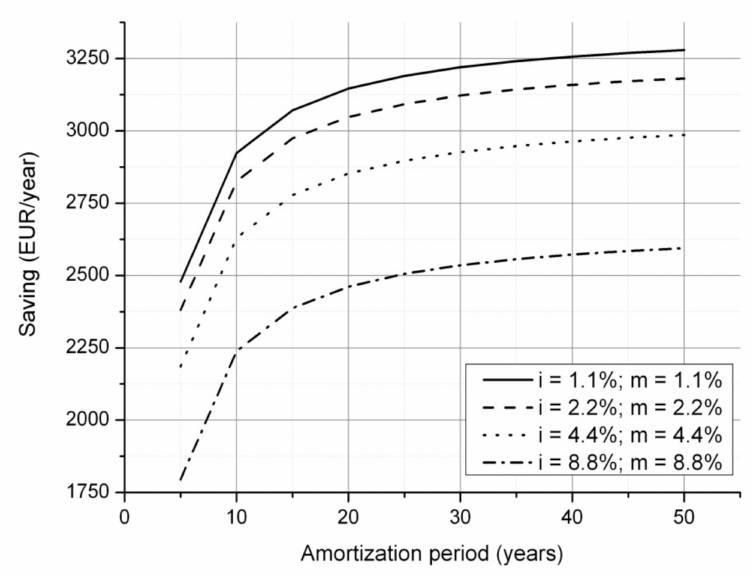
Figure 4. Dependence of the amortization period on savings for various values of i—interest rate and m—service rate.